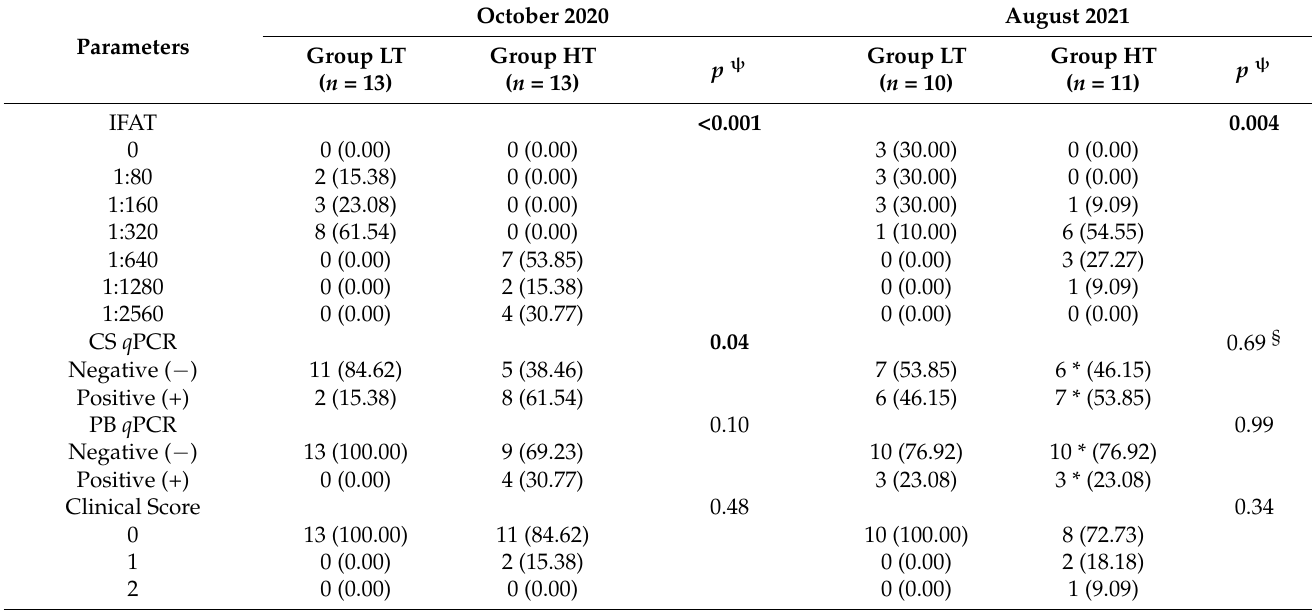
Table 3. Comparison of diagnostic tests results and clinical score between dogs of the low titre group (Group LT) and the high titre group (Group HT) in October 2020 and in August